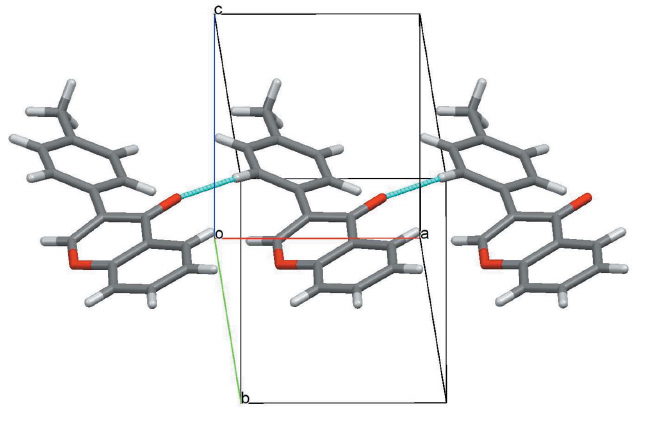
Figure 2 Part of the crystal structure of the title compound with C—H (cid:3)(cid:3)(cid:3) O hydrogen bonds shown as dashed lines.